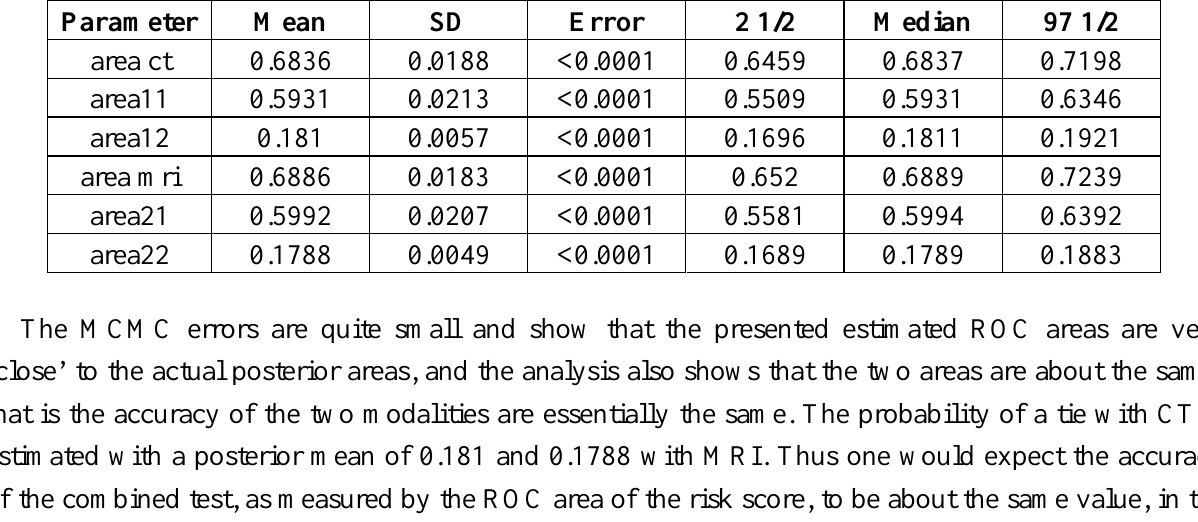
Table 28. Posterior analysis for MRI and CT of individual ROC